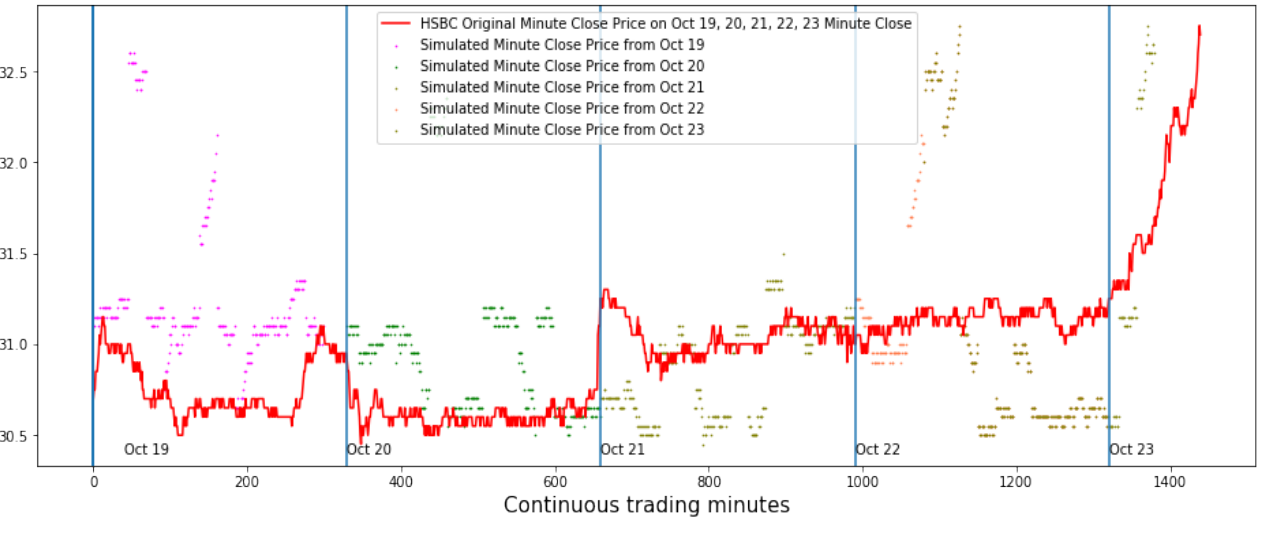
Figure 5. For the consecutive trading minutes from 19 October to 23 October 2021, we plotted the min- utes trading level (X-axis) and minute interval close prices (color red), with the simulated/generated prices in other colours. The open market auction impacts the morning continuous trading session after 9:30 a.m. And starting from 3:30 p.m., there exists market impact caused by China Connect until market